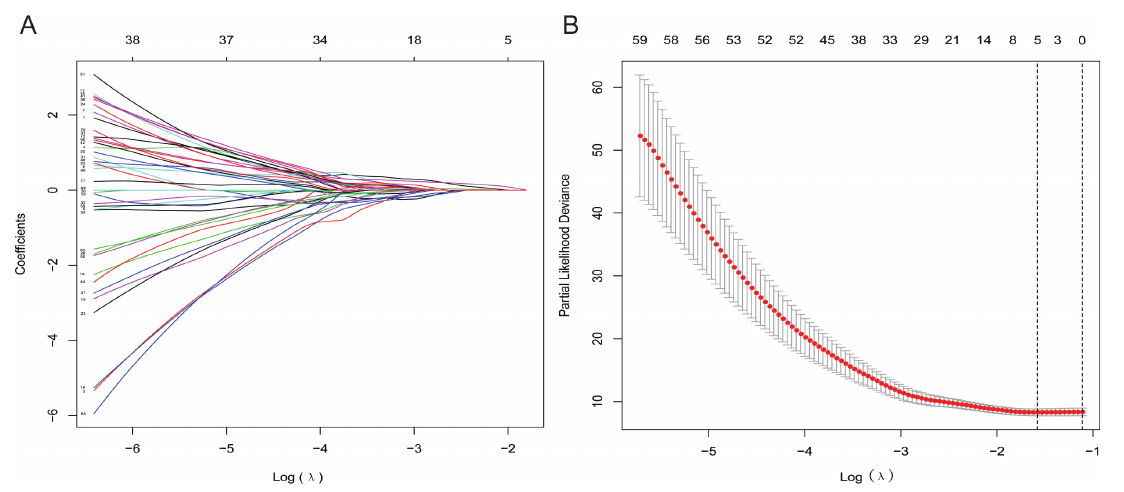
Figure 5. Lasso regression process. (A) Lasso diagram shows the dynamic process of screening variables; (B) the selection process of the cross-validation parameter